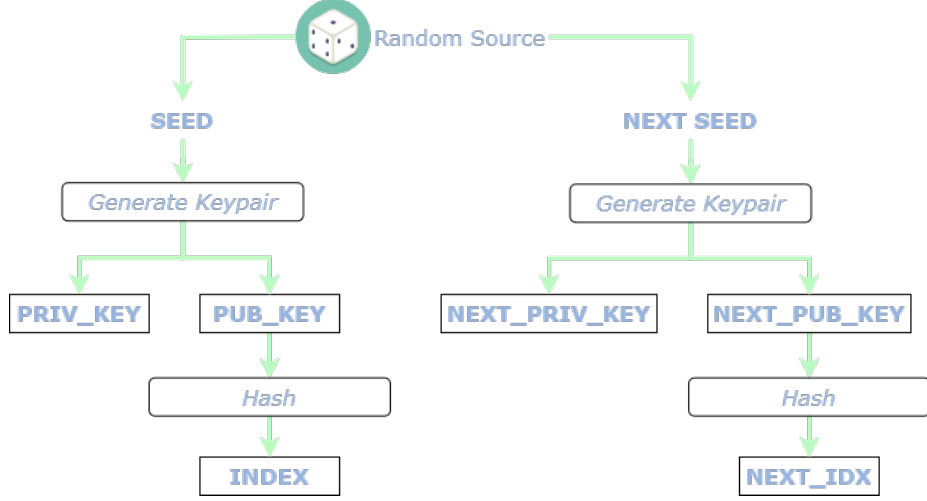
Figure 4. Generation of Index and Next Index